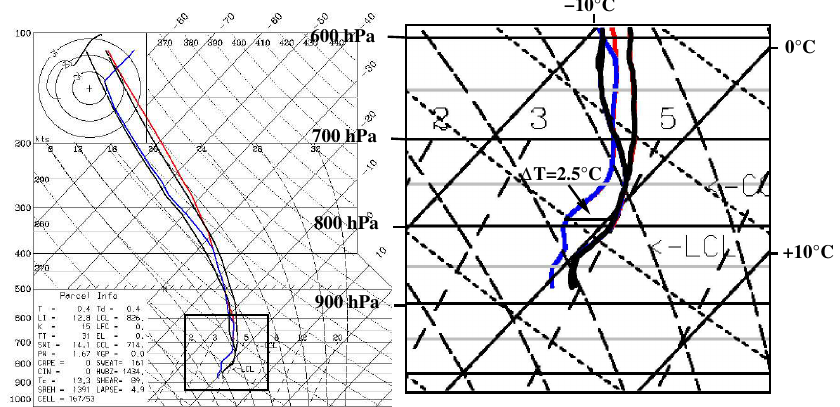
Figure 12: Skew-T diagram at location B (cf. Fig. 4) at 0600 UTC 16 September 2004, Thompson micro-physics scheme (blue and red lines) and the WSM6 scheme (black lines). The zoomed-in figure to the right shows that the maximum temperature difference (2.5 ◦ C) between the two schemes is at approximately 800 hPa height. Table 4. The square of the simulated Brunt-Väisälä frequency (N 2 ) [s − 2 ] at point BV on 16 September, 06:00UTC at various pressure levels q g d θ for all ten simulations. Here, N is defined as , where θ is the dry (upper row) and moist (lower row) equivelant potential temperature, θ d z g is the local acceleration of gravity, and z is geometric